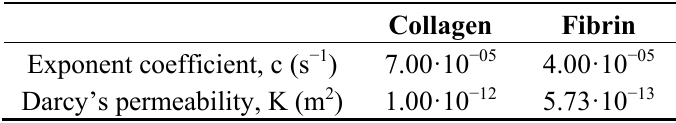
Figure 5. Pressure difference drop over time in hydrogels. The experimental data points of the pressure difference vs. time were plotted and fitted to an exponential function for fibrin ( left ) and collagen ( right ) gels. The resulting expressions and R 2 values are also indicated. The exponent coefficient determines the value of the permeability ( (cid:1837) ). Table 2. Resistance to fluid